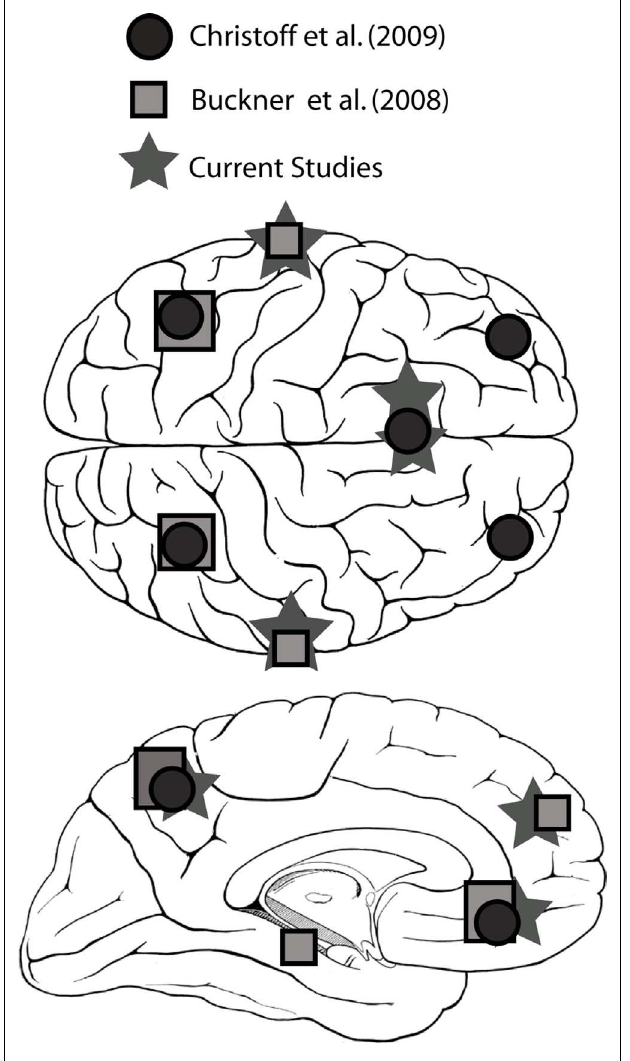
FIGURE 2 | Brain regions identified with the default network in several fMRI studies (Buckner et al., 2007; Christoff et al., 2009) and in the current